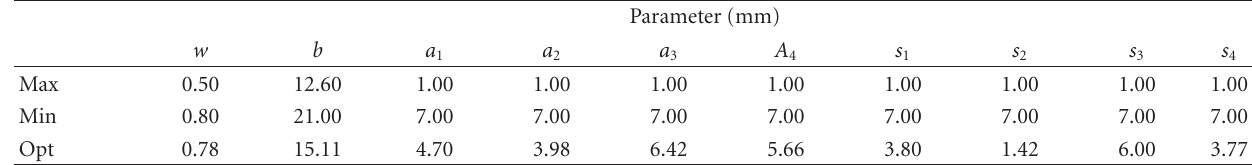
Table 1: Optimization problem variables for multiobjective formulation.